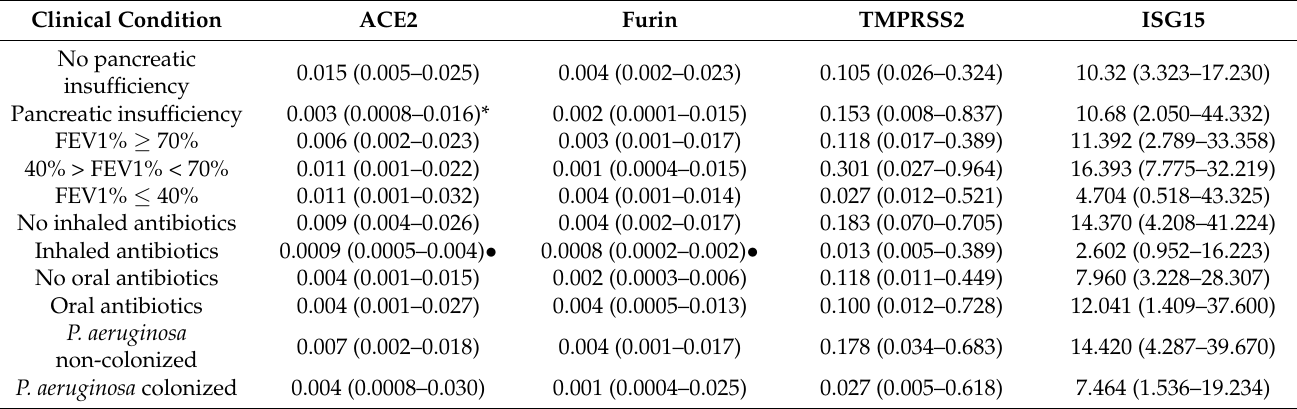
Table 2. Expression levels of ACE2, furin, TMPRSS2 and ISG15 in cystic fibrosis (CF) patients ( n = 46), according to the main clinical